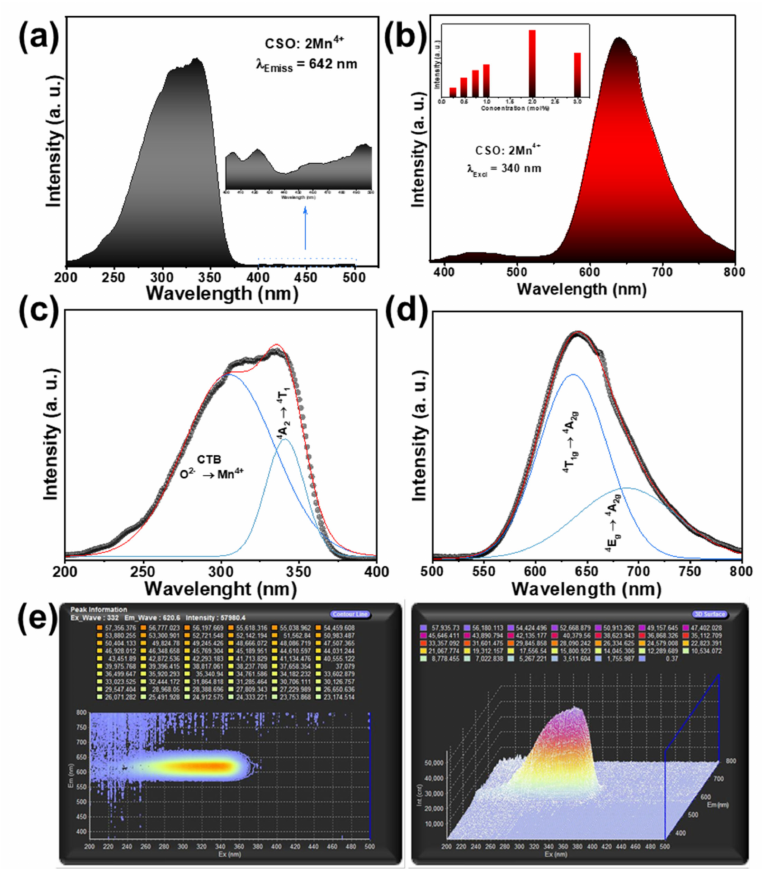
Figure 3. ( a ) PLE, ( b ) PL, ( c , d ) Gaussian fitting results and ( e ) 3D luminescence of CSO: 2Mn 4+ . Inset of ( b ) shows a graph of intensity variation with different concentrations of Mn